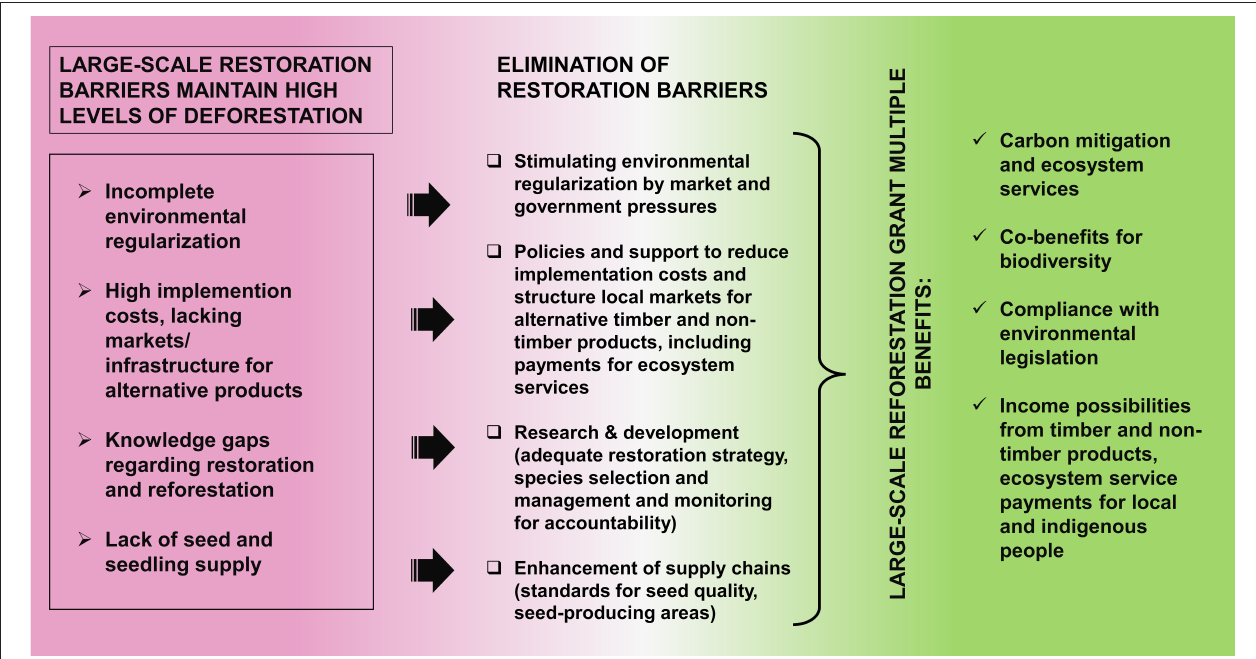
FIGURE 1 | The elimination of restoration barriers enables society to take advantage of multiple benefits resulting from reduced deforestation rates and increasing forest